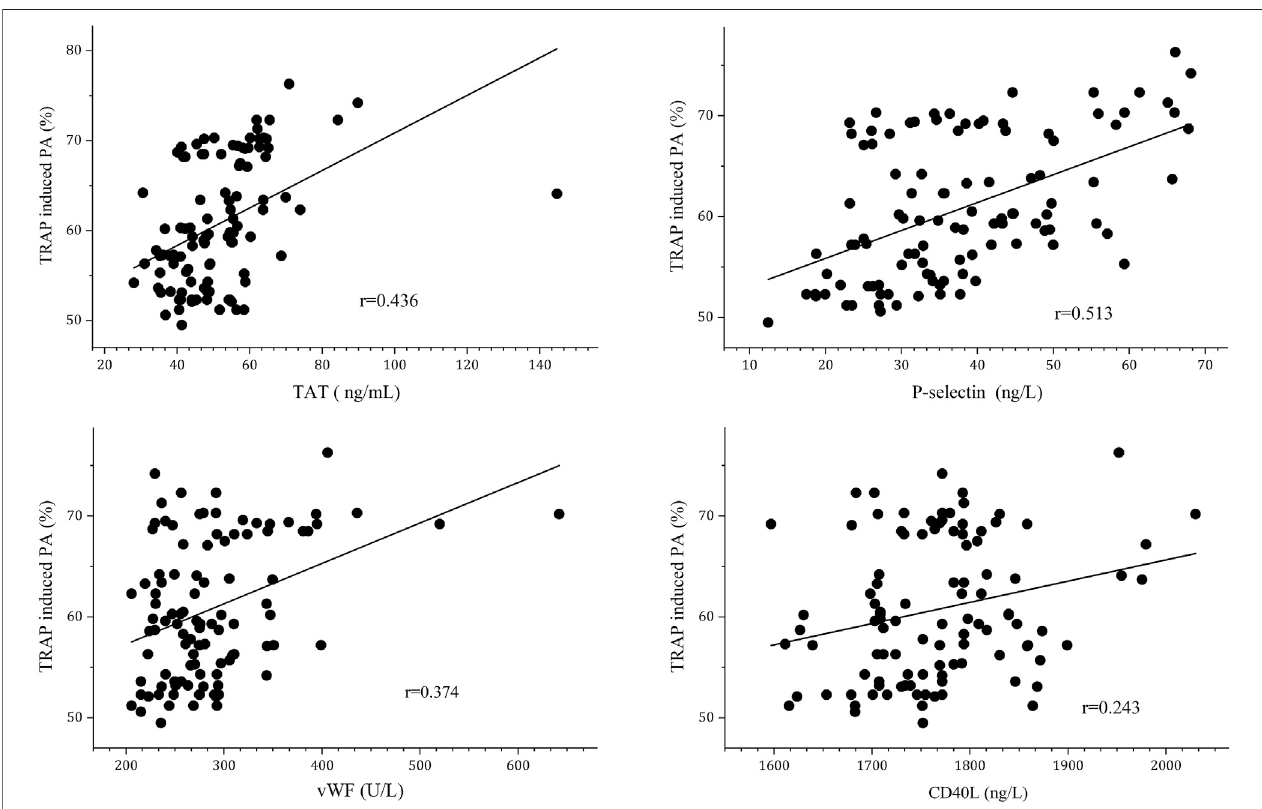
FIGURE 3 | Correlation between TRAP-induced PA and platelet activation biomarkers.